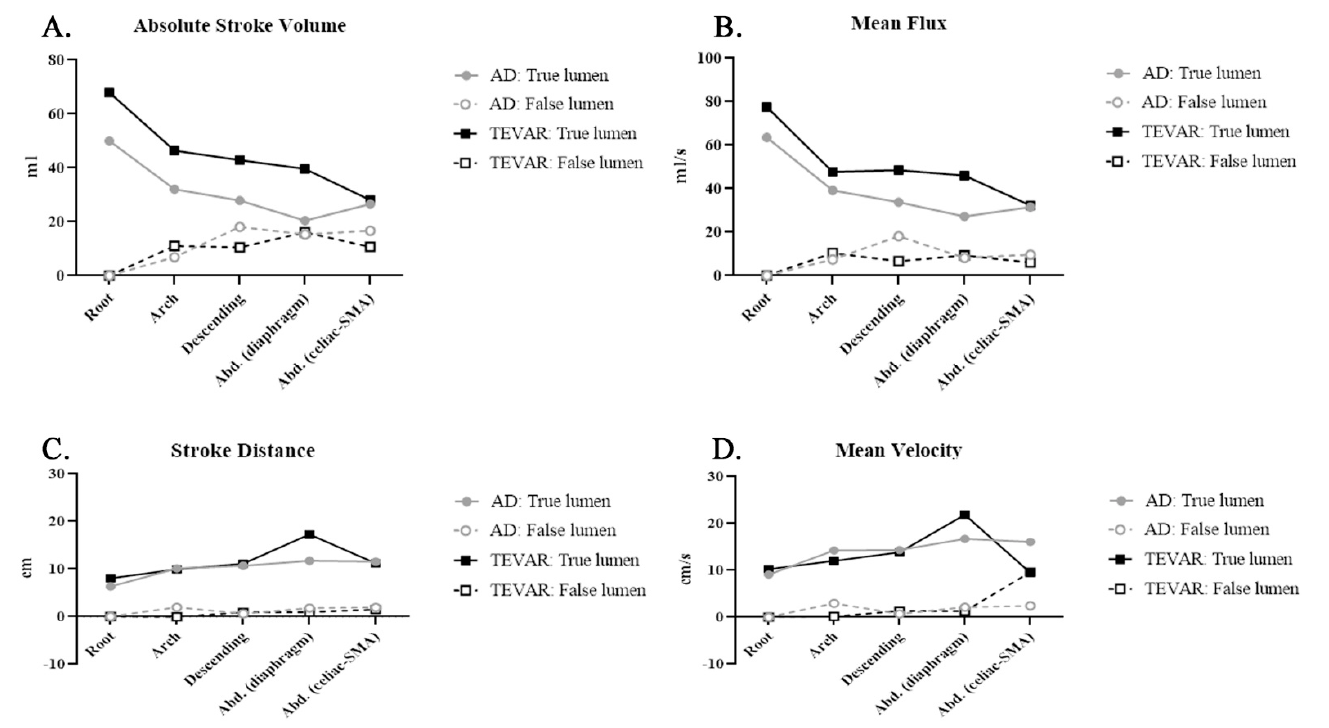
Figure 3. Phase-contrast magnetic resonance imaging (PC-MRI) quantitative flow measurements after thoracic endovascular aortic repair (TEVAR) compared with those before TEVAR: ( A ) absolute stroke volume (ASV): ASV in the true lumen increased in a manner similar to the increase in stroke volume; ( B ) mean flux (MF): MF decreased in the false lumen in the aortic arch; ( C ) stroke distance (SD): SD in the true lumen increased after TEVAR; ( D ) mean velocity (MV): MV in the true lumen increased after TEVAR.